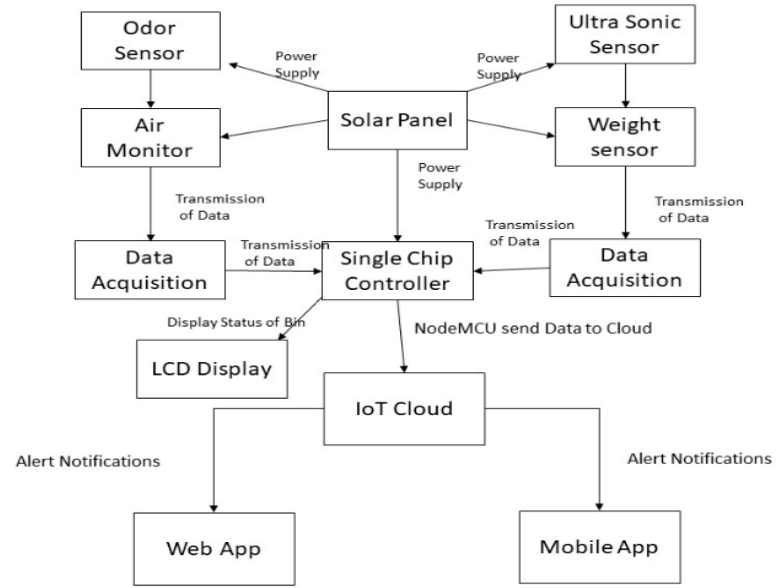
Figure 1. Overall design flow chart.